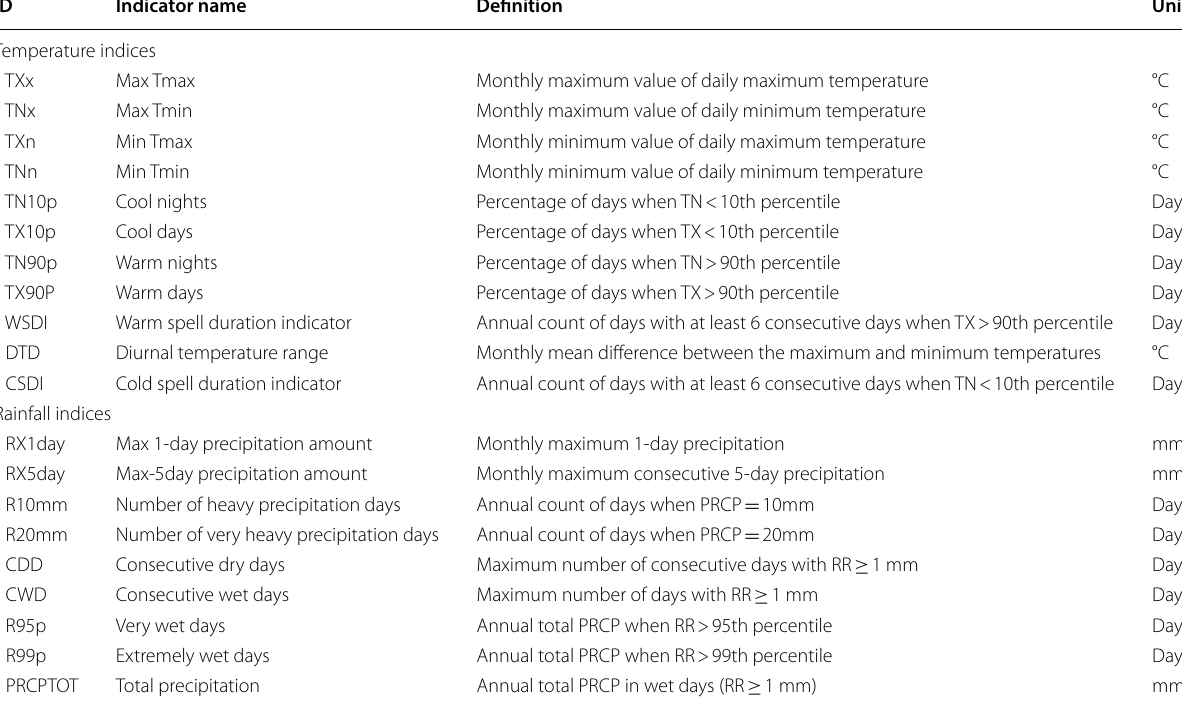
Table 2 List of temperature and rainfall